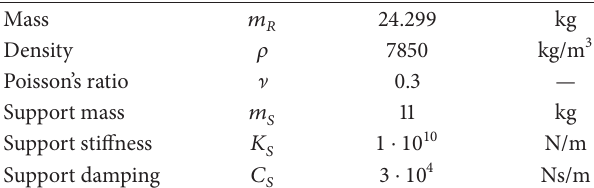
Table 5: Rotating structure properties.